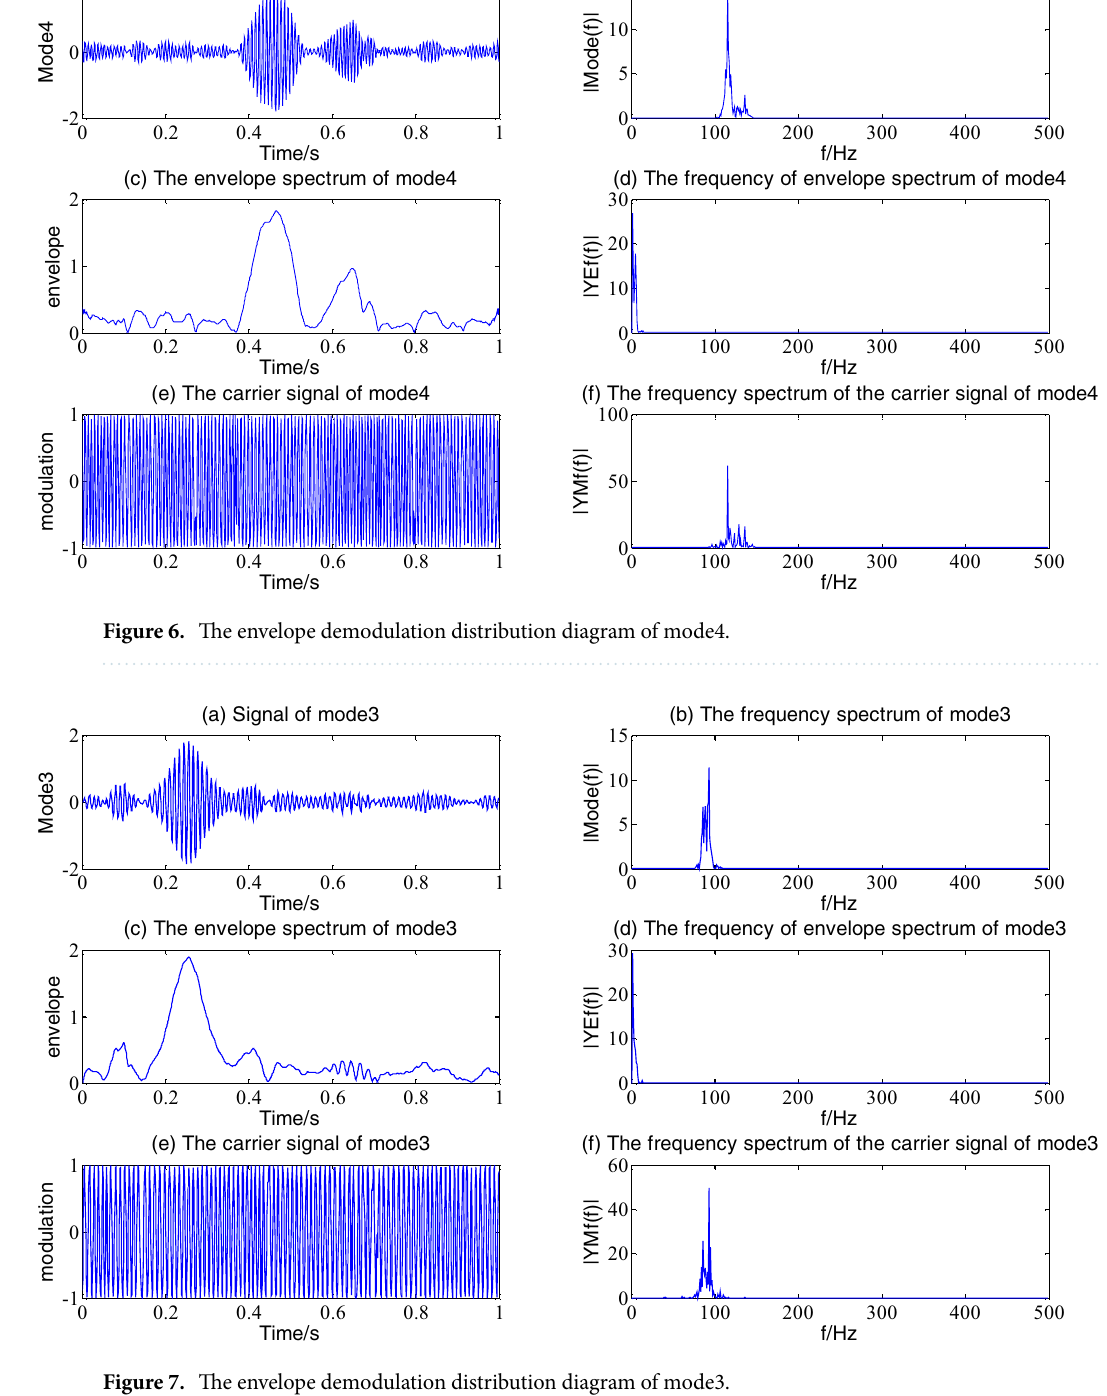
Figure 7. The envelope demodulation distribution diagram of